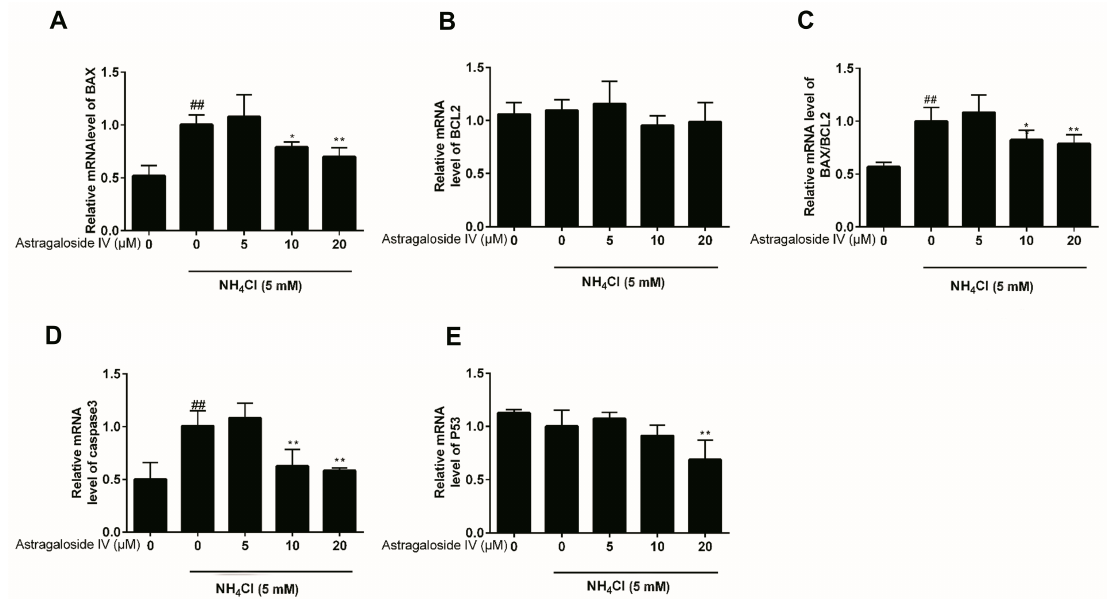
Figure 2. The protective effects of astragaloside IV on mRNA expressions of genes ( BAX , caspase 3 , BCL2 , BAX/BCL2 and p53 ) induced by ammonia in MAC-T cells. The MAC-T cells were pretreated with different concentrations of astragaloside IV (0, 5, 10 and 20 µ M) for 4 h, followed by NH 4 Cl (5 mM) treatment for 24 h. Apoptosis-related genes ( BAX ( A ), BCL-2 ( B ), BAX/BCL2 ( C ), caspase3 ( D ), and p53 ( E )) were analyzed by quantitative real-time PCR. The data are shown as mean ± SD. n = 4. *, p < 0.05; **, p < 0.01. ## indicates a significant difference from untreated cells at p < 0.01.